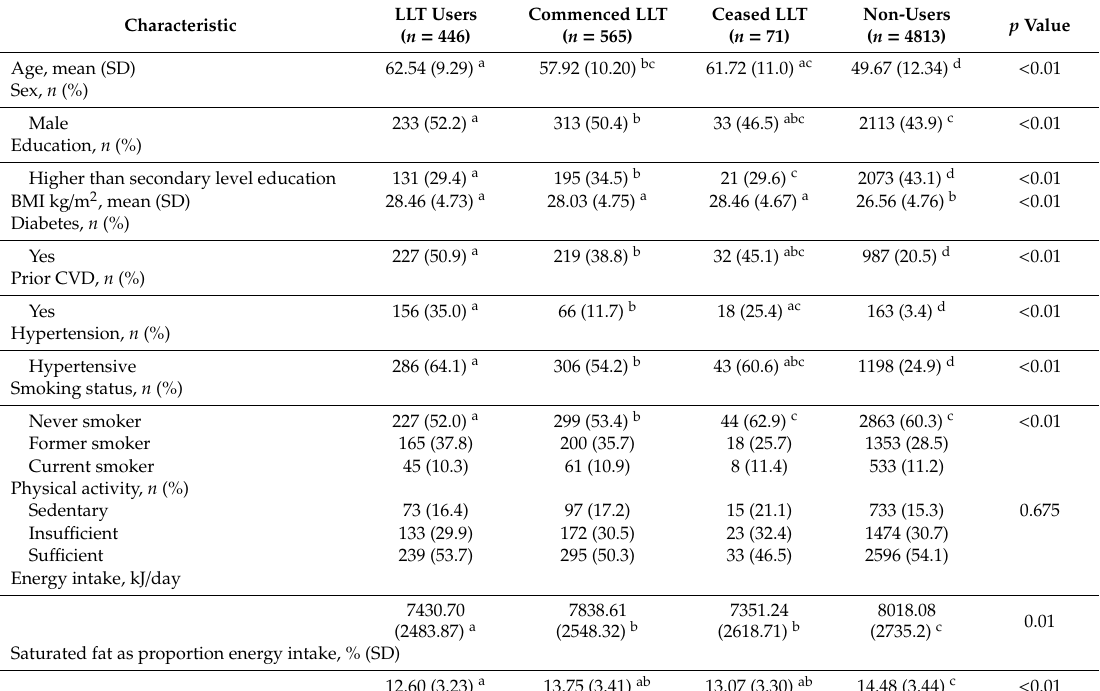
Table 1. Baseline characteristics of study population by lipid-lowering therapy